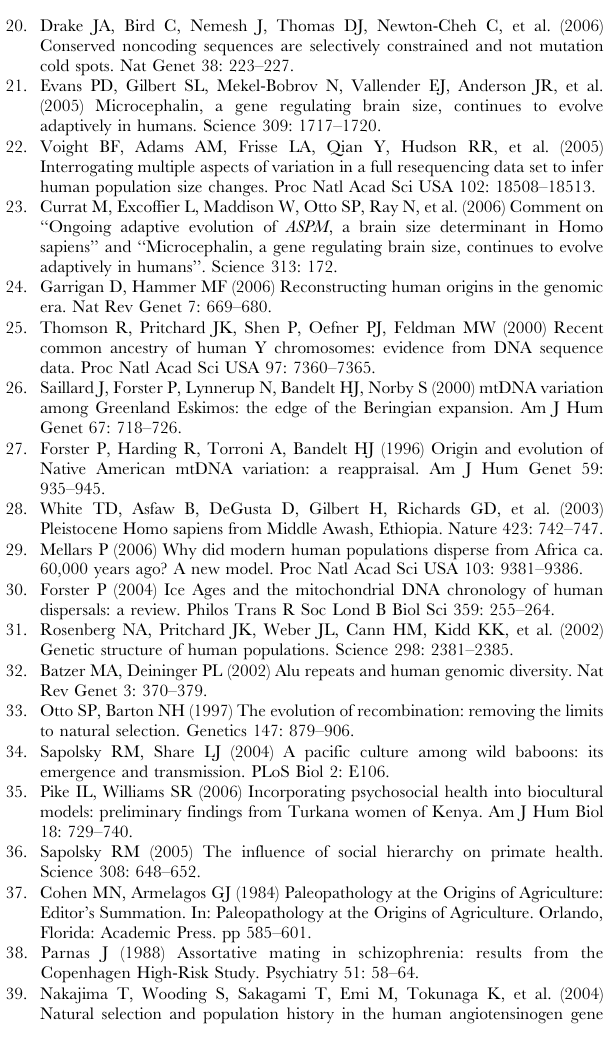
report, which employed the HapMap Phase II data. The red box indicates the region of GABRB2 studied. Figure S4 Summary statistics for all HG-N and HG-D haplotypes. Tajima’s D and Fu and Li’s D values are plotted for AF, GE, US and JP. Found at: doi:10.1371/journal.pone.0000462.s011 (0.97 MB